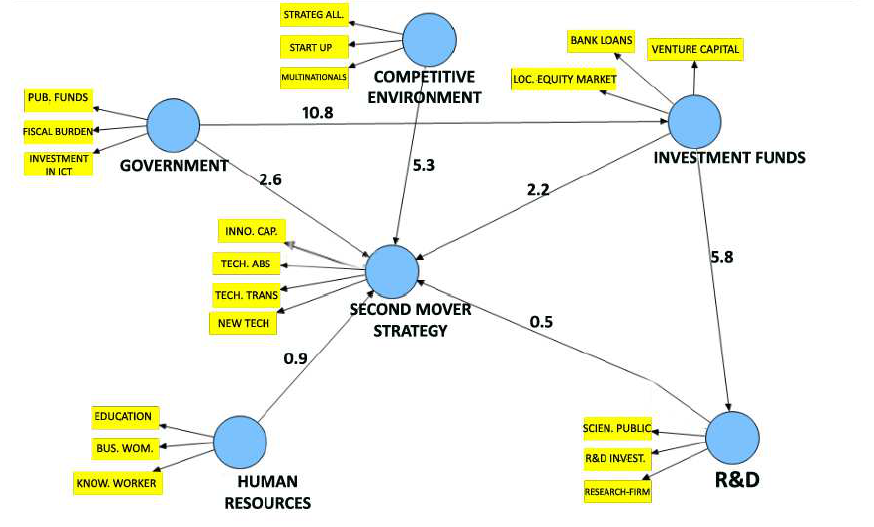
Figure 2: Evaluation between Exogenous LV with Endogenous LV via Bootstrap